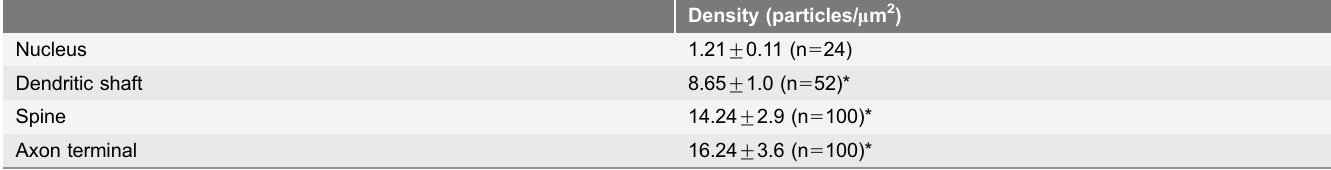
Table 1. Densities of gold particles coding for Sept7 in different subcellular